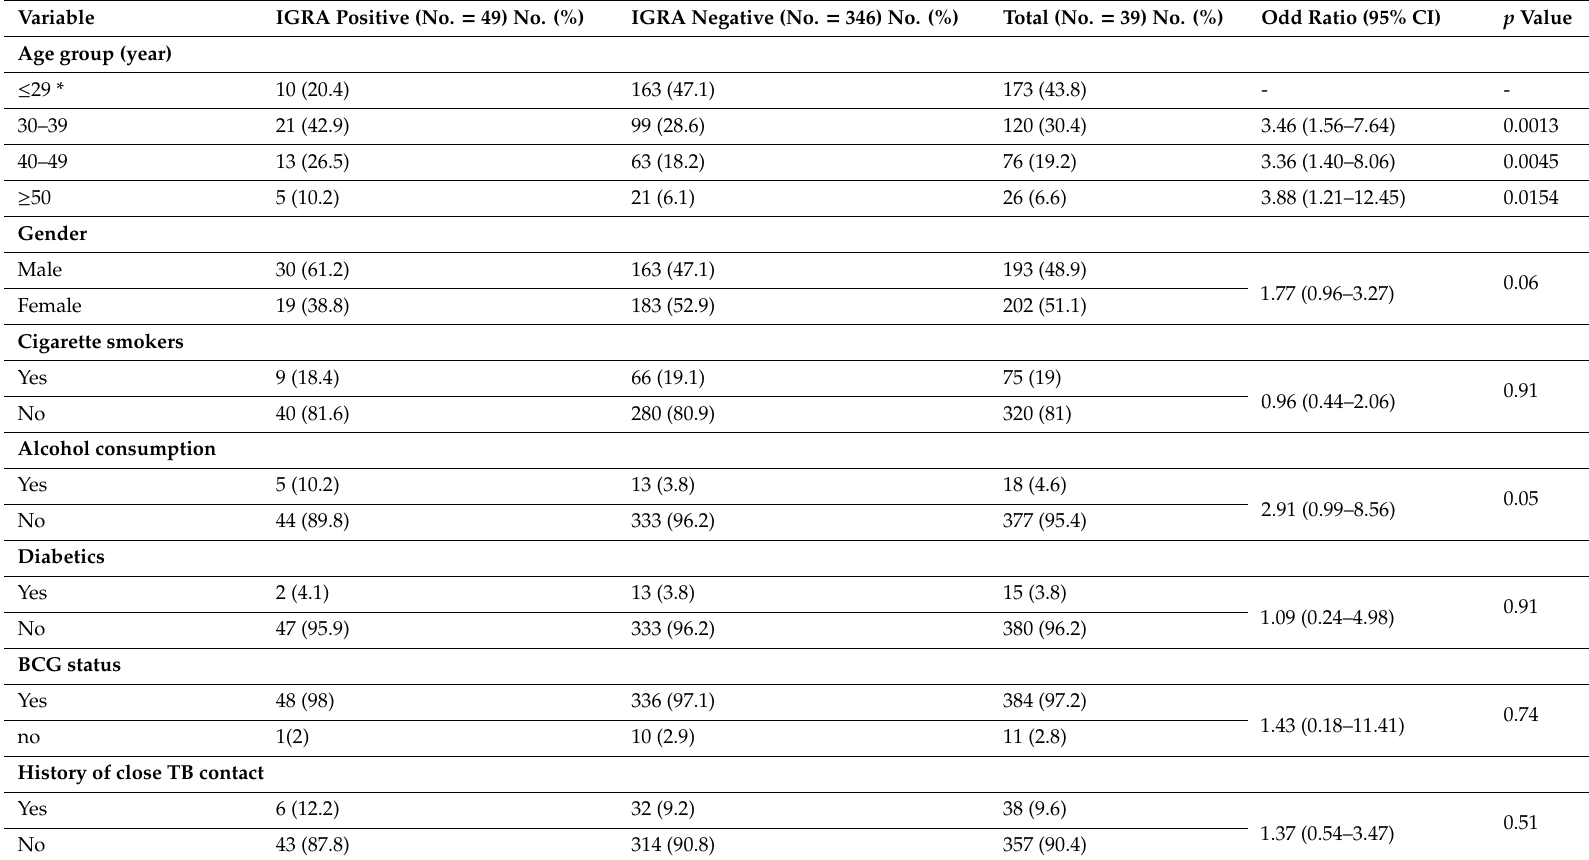
Table 2. Univariate analysis of associated risk factors with positive IGRA